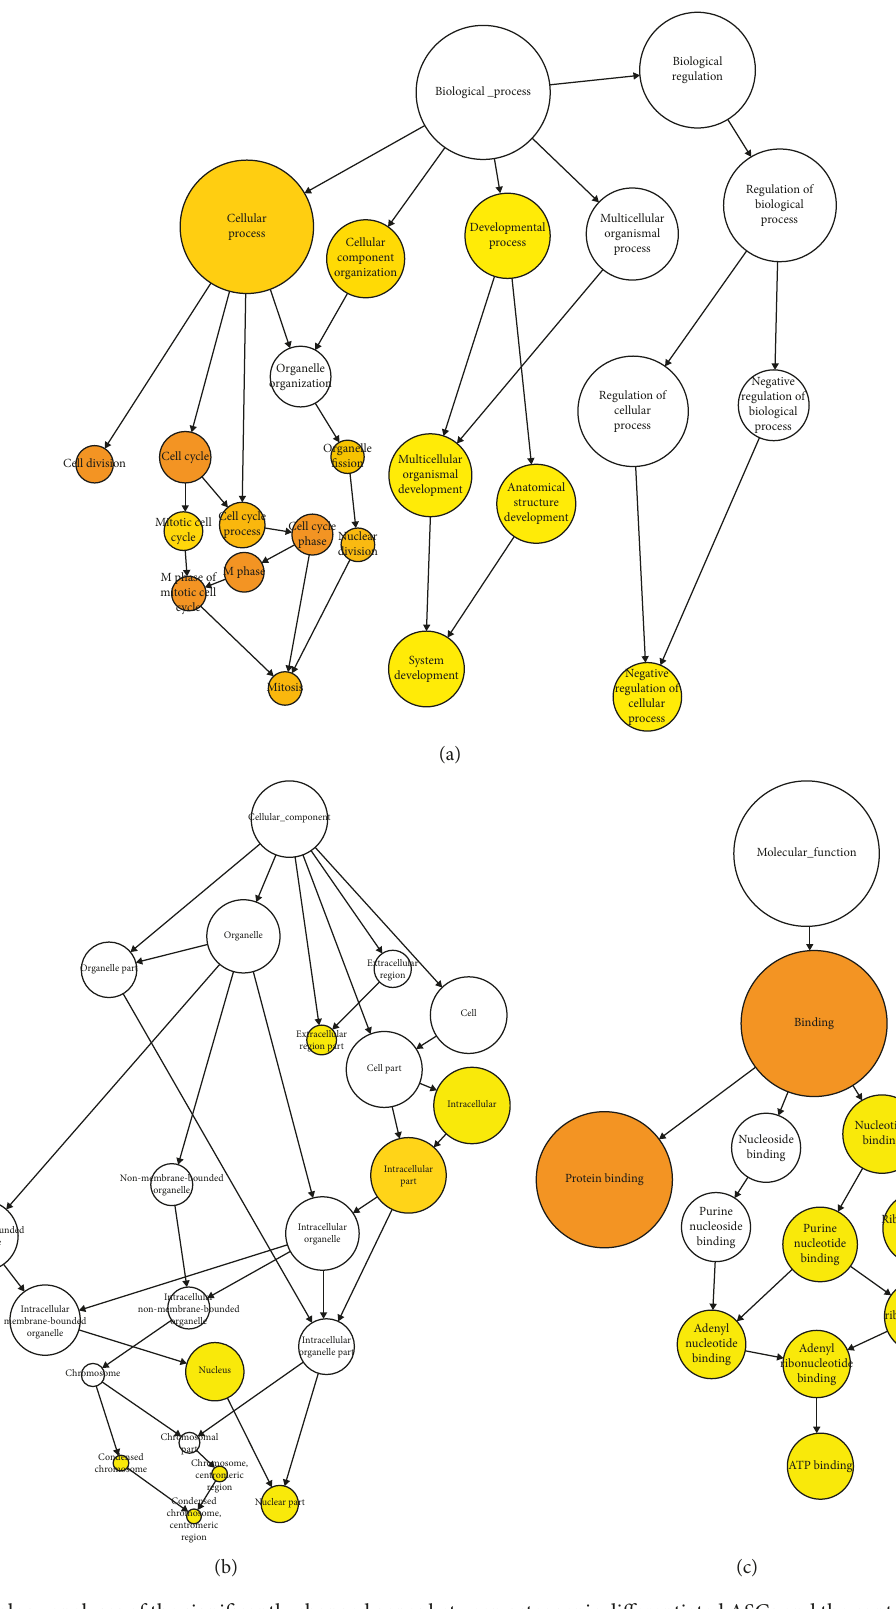
Figure 3: Gene ontology analyses of the signi fi cantly changed genes between osteogenic di ff erentiated ASCs and the control cells according to their biological process, cellular component, and molecular